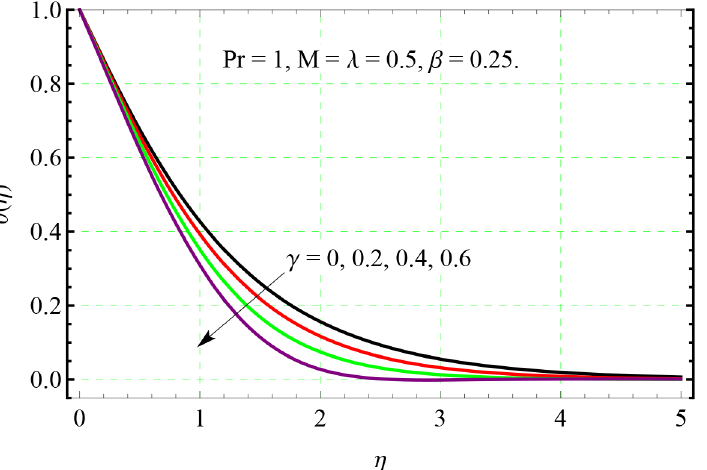
Fig 11. Effect of γ on θ ( η ).